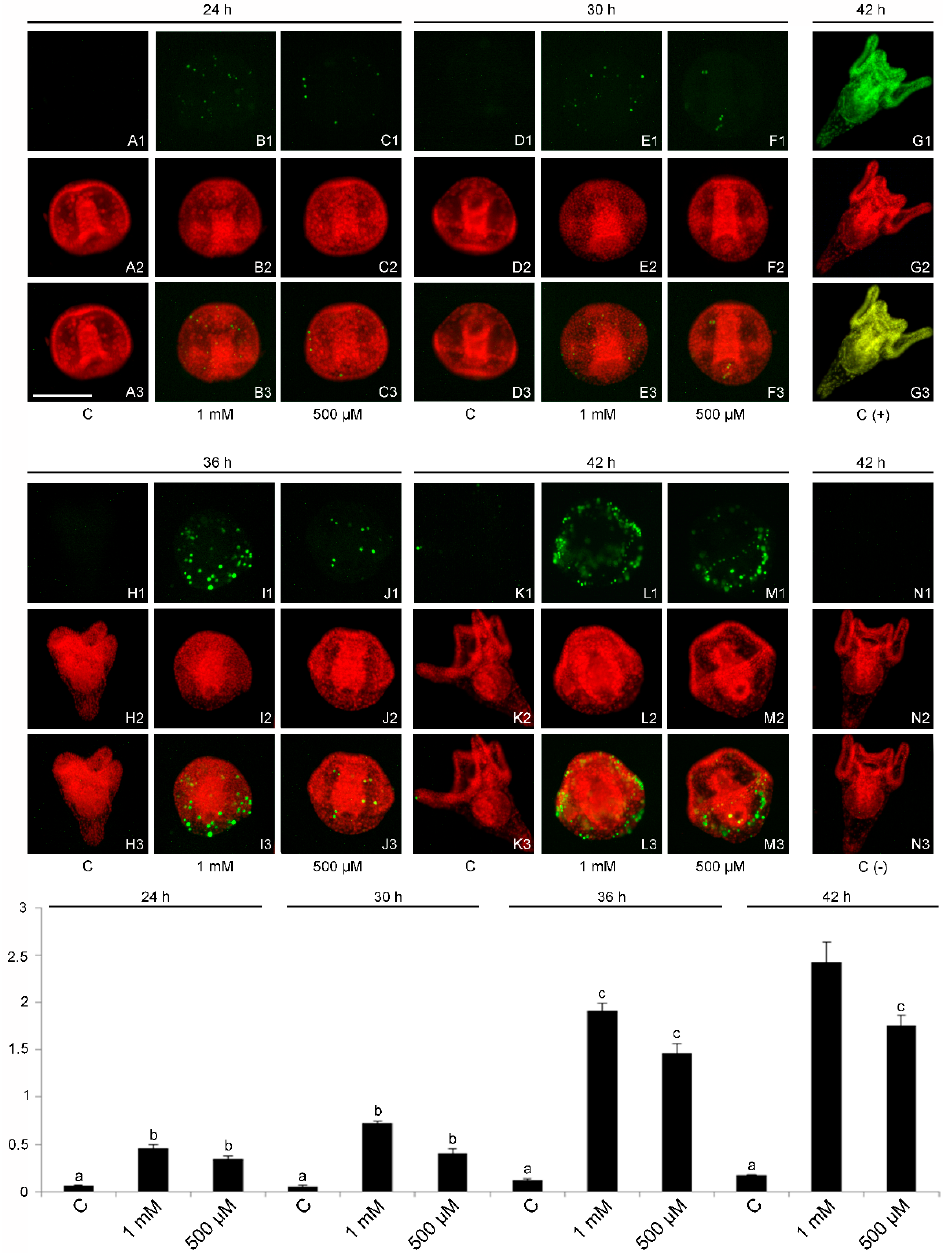
Figure 5. Fluorescent TUNEL assay and densitometric analysis. Pictures of demonstrative embryos at 24, 30, 36 and 42 h of development/treatment. DNA fragmentation ( A1 – N1 ). Nuclei marked with propidium iodide ( A2 – N2 ). Merge of both signals ( A3 – N3 ). Control embryos ( A1 – A3 , D1 – D3 , H1 –